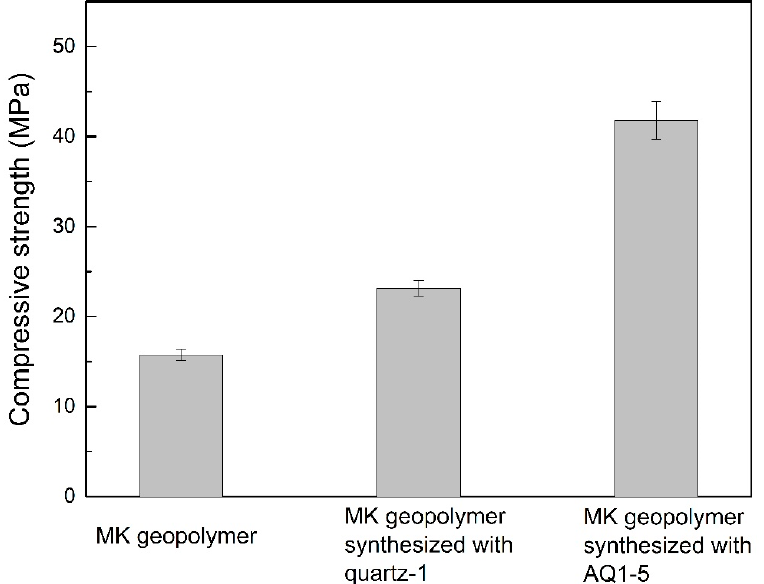
Figure 9. The compressive strength of the MK geopolymer and MK-based geopolymers synthesized with quartz-1 and AQ1-5.